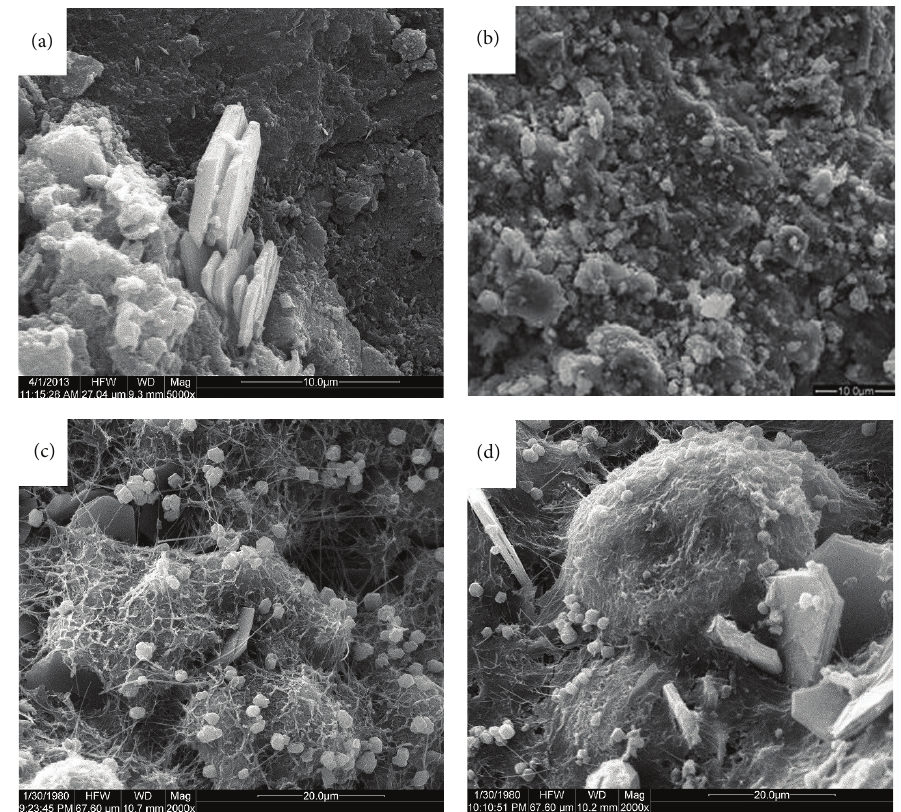
Figure 12: Microstructure of hydration products of (a) C, (b) L2, (c) R2, and (d) G2 at 90d.